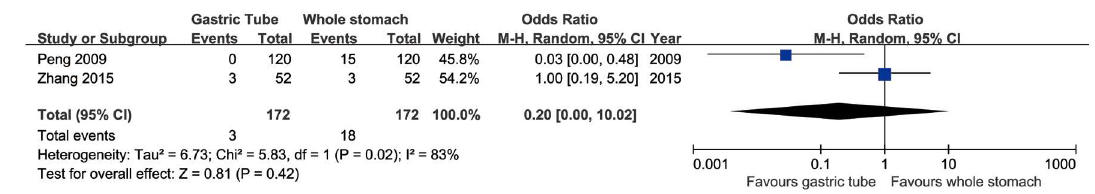
Fig 6. Forest plot of delayed gastric emptying in the whole-stomach and gastric-tube groups.